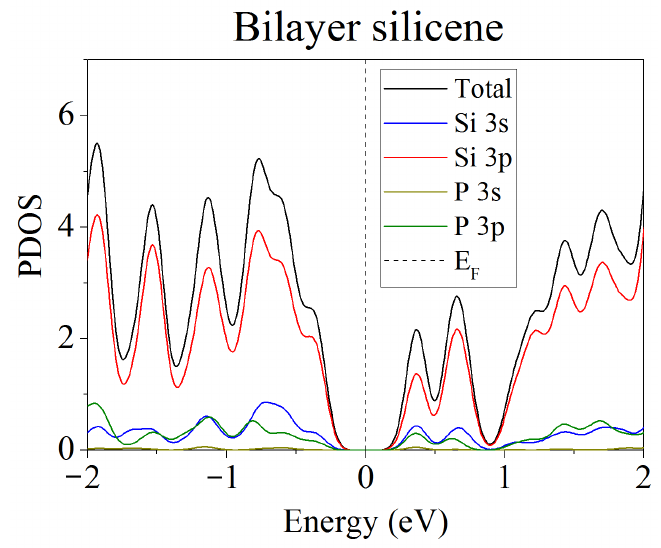
Figure 3. Partial spectrum of electronic states of two-layer silicene obtained after the replacement of 2 Si atoms belonging to each of the lower sublattices by phosphorus. Adapted with permission from Ref. [48]. 2020, Springer.